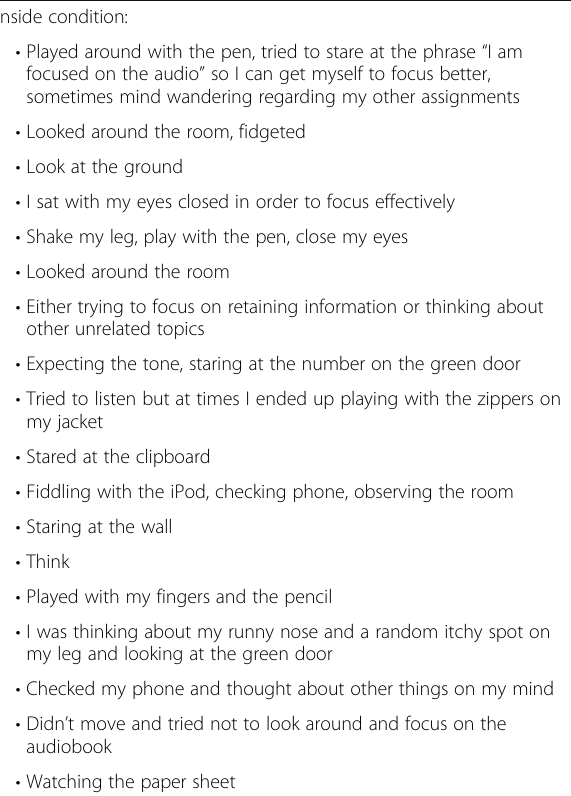
Table 3 Free-form responses to end-of-study questionnaire Question 1 ( “ What did you do while listening to the